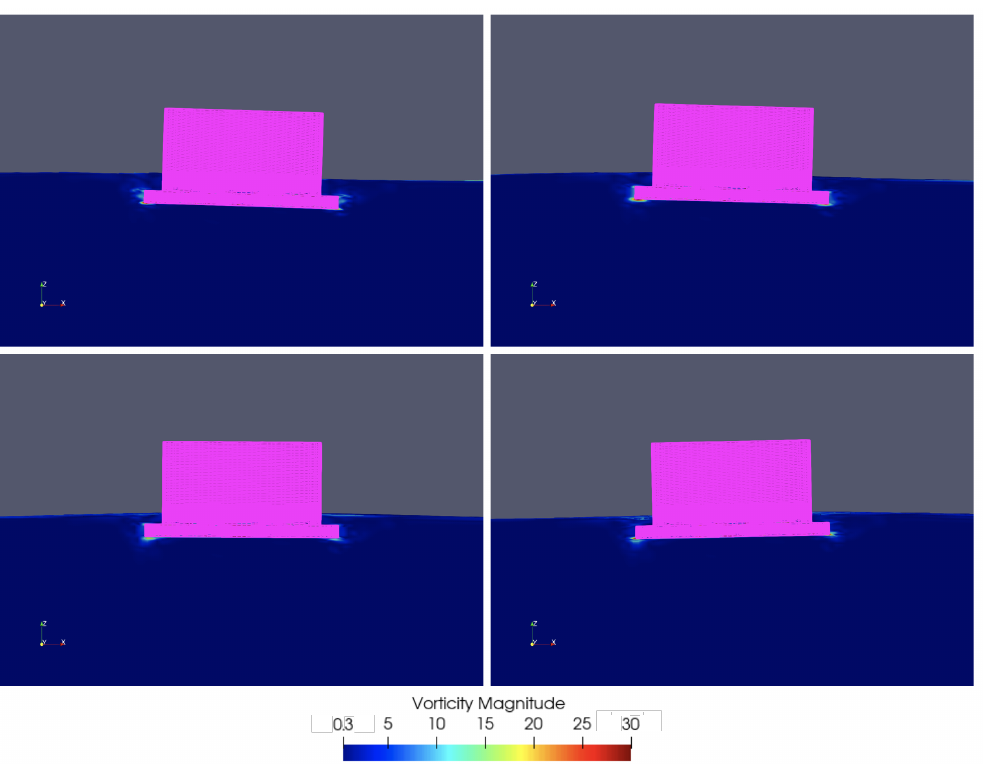
Figure 19. Snapshots of the magnitude of the vorticity near the skirt with H = 2.72 cm and T = 1.4 s from t / T = 25.5 to 26.